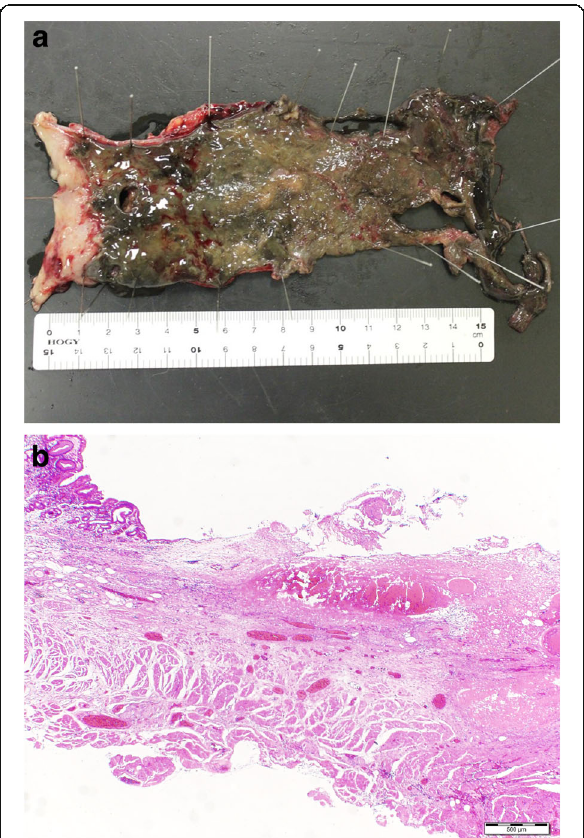
Fig. 4 Findings of surgical and pathologic specimen (×20 HE). a Black pigmented esophageal mucosa and perforation of the esophagus. No discoloration in the gastric mucosa. b Necrosis and deciduation of the esophageal mucosa. Gastric mucosa remained